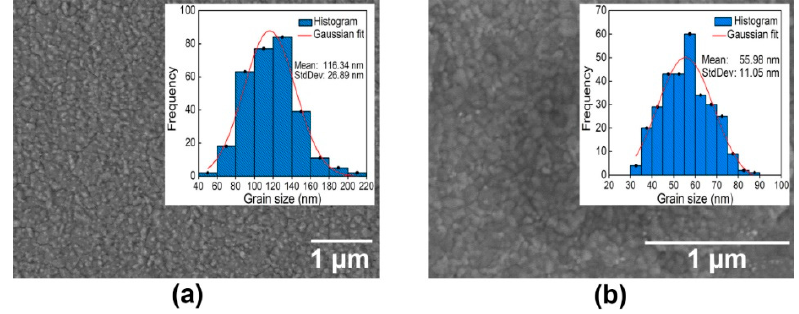
Figure 7. Morphology characterization (SEM): ( a ) LTO:Fe-HC; ( b ) LTO:Fe-LC.